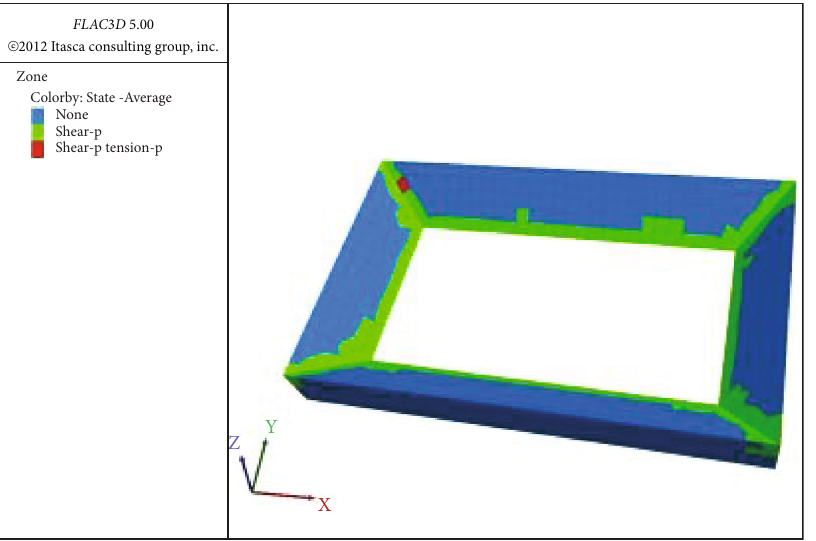
Figure 7: Cloud diagram of the plastic zone of unreinforced boat pond when coalface advanced